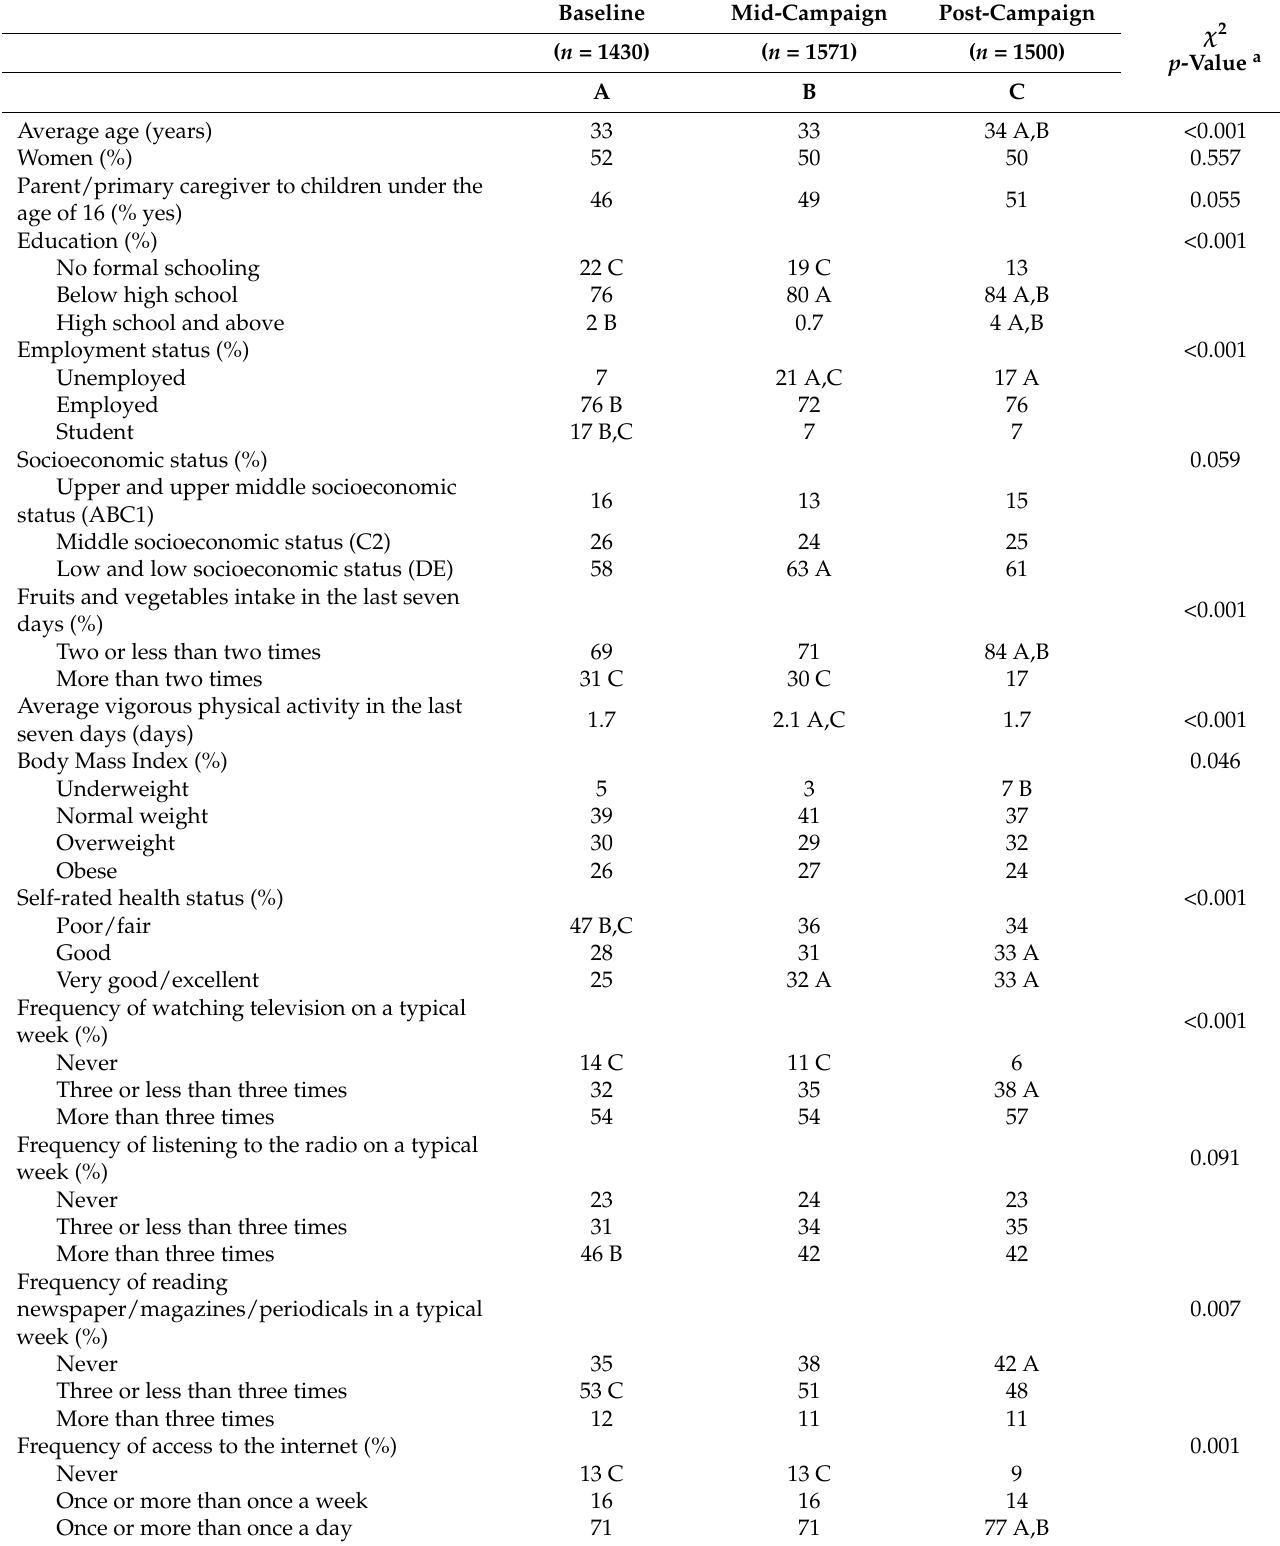
Table 2. Demographics characteristics of survey respondents in baseline, mid-campaign, and